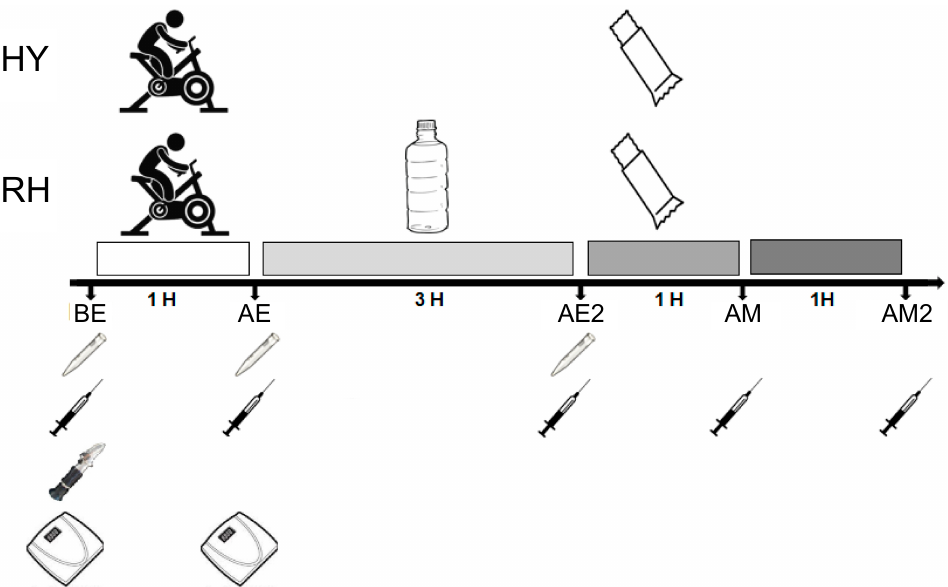
Figure 1. Experimental protocol. BE = pre-exercise; AE = after exercise; AE2 = after hydration trials; AM = after meal; AM2 = 2 h after meal.